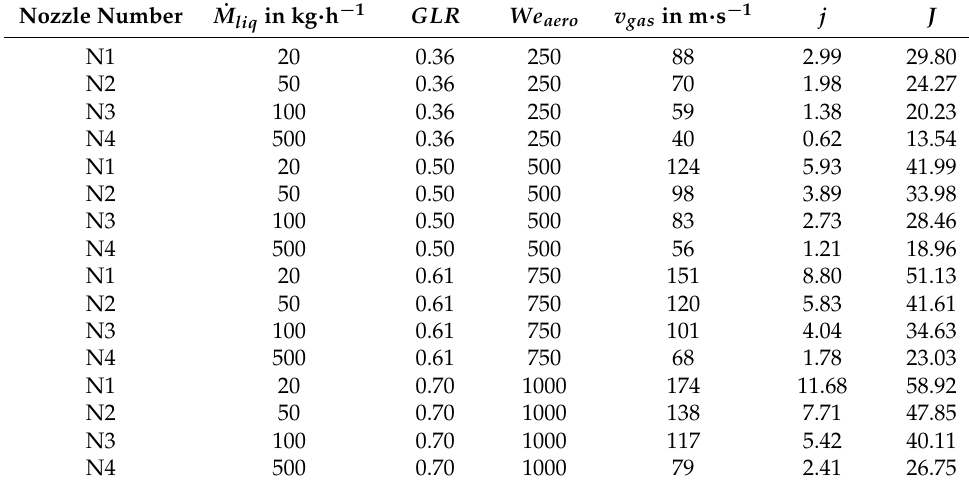
Table 3. Operating conditions and calculated dimensionless